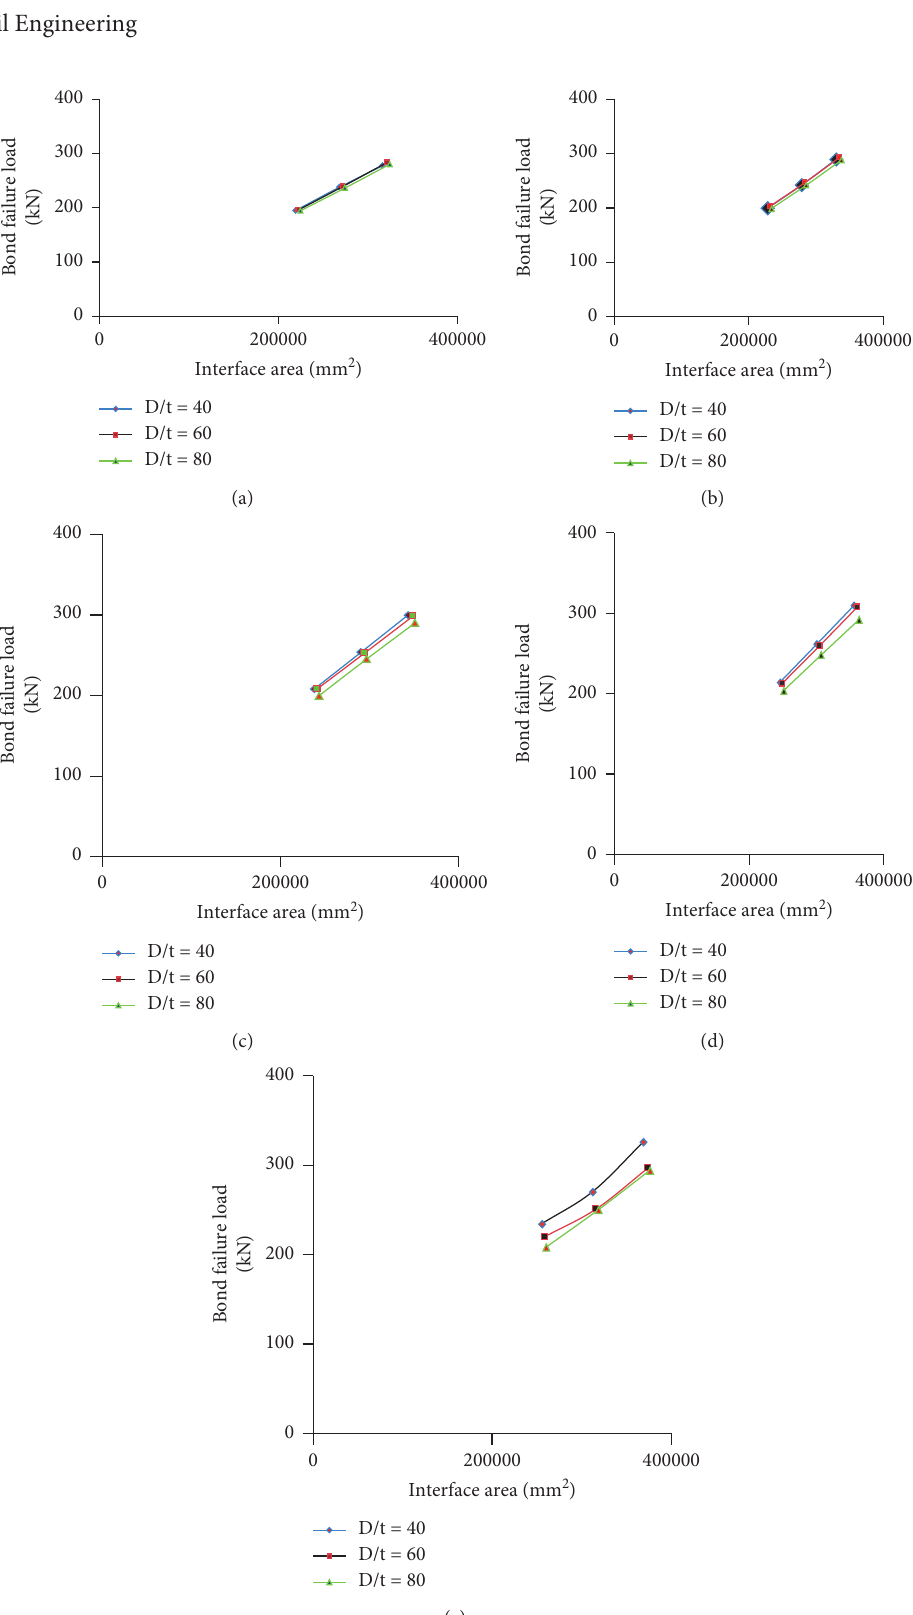
Figure 10: Bond failure load vs. interface area. No. of flutes: (a) 2; (b) 3; (c) 4; (d) 5; (e)